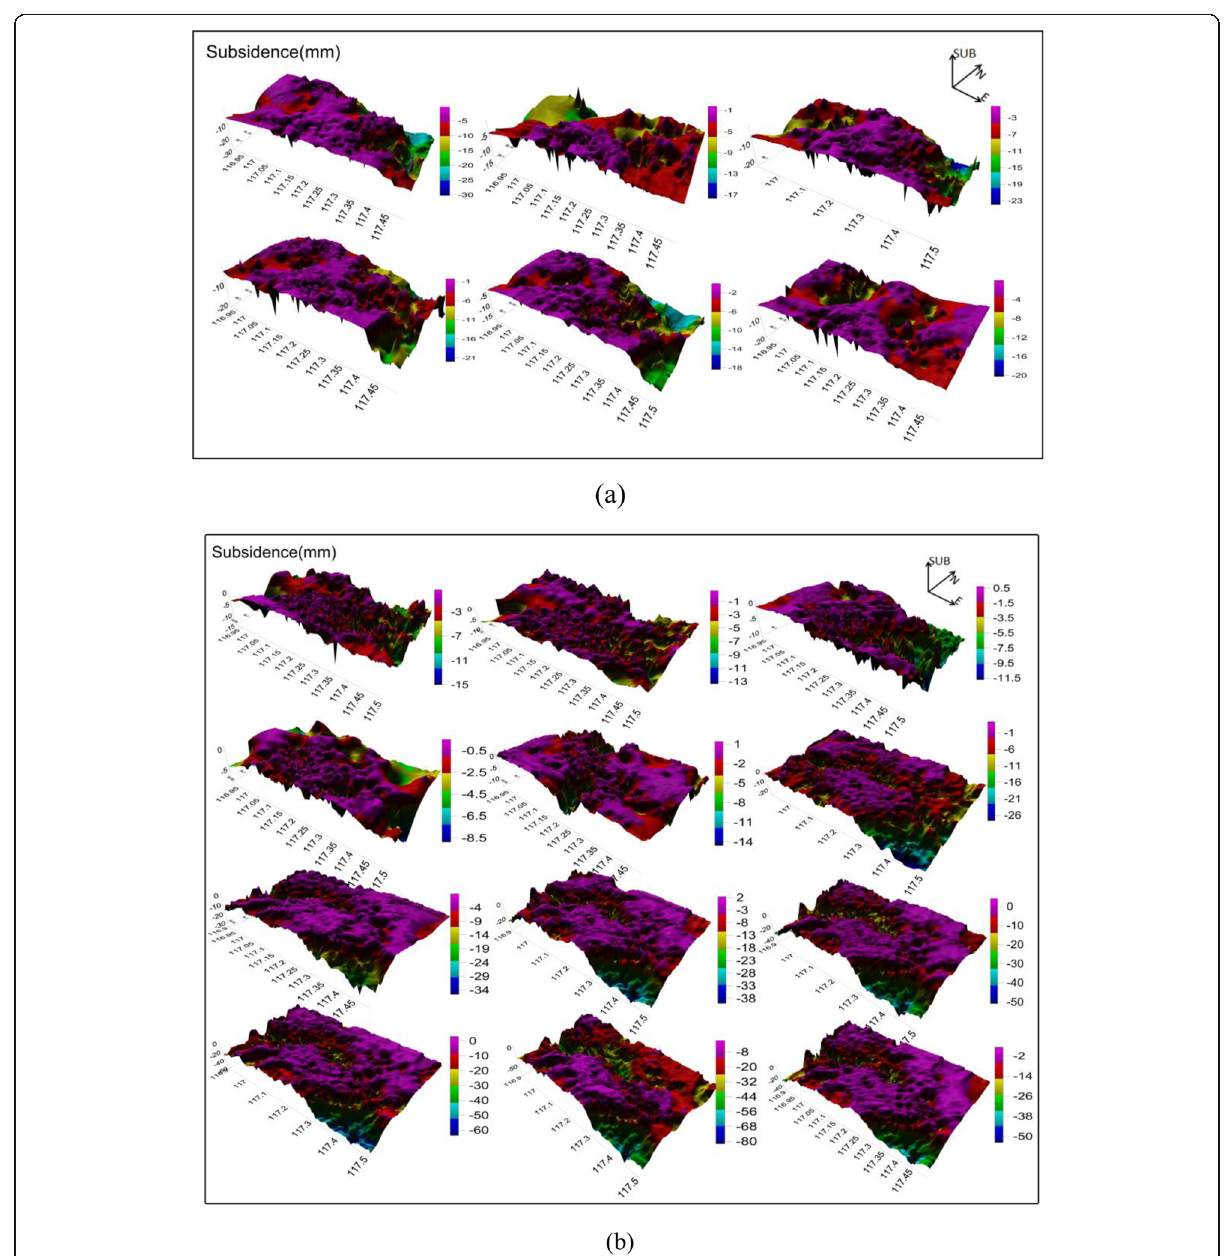
Fig. 8 Time-series surface deformation estimated by SBAS-InSAR. Time interval 35 days. a 2007. b 2008 –